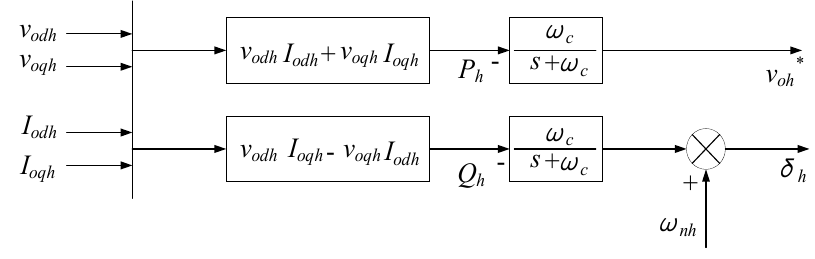
Figure 5. Harmonic droop control block diagram.